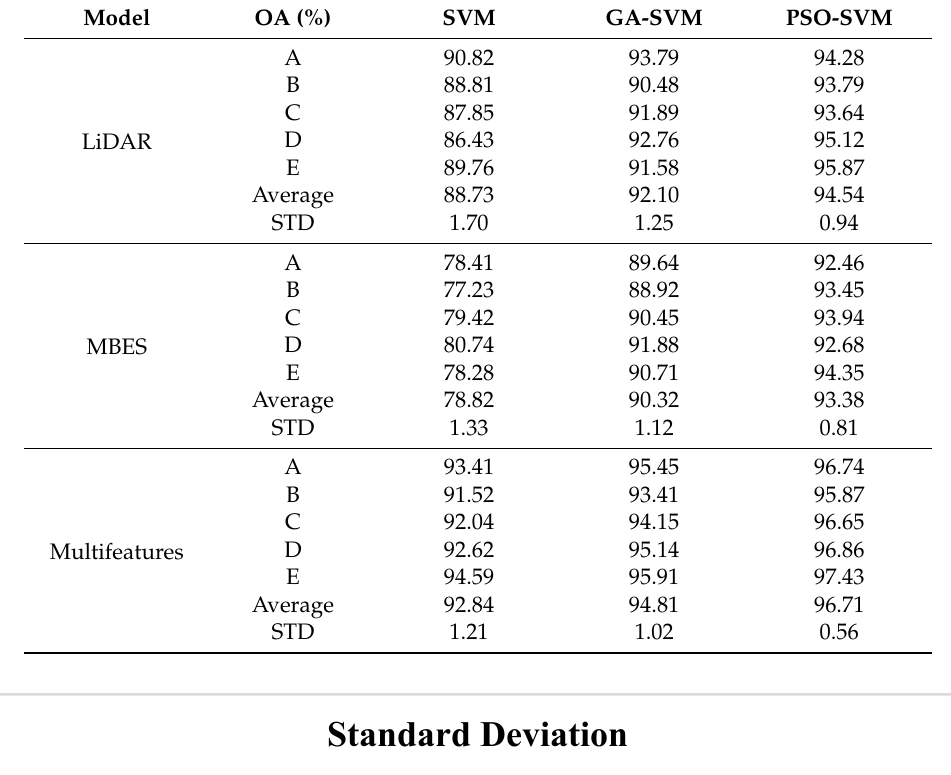
Table 6. Model evaluation results based on five-fold cross validation. STD, standard deviation.